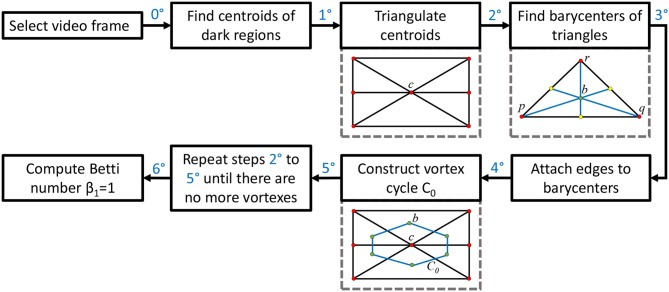
Method flow graph.